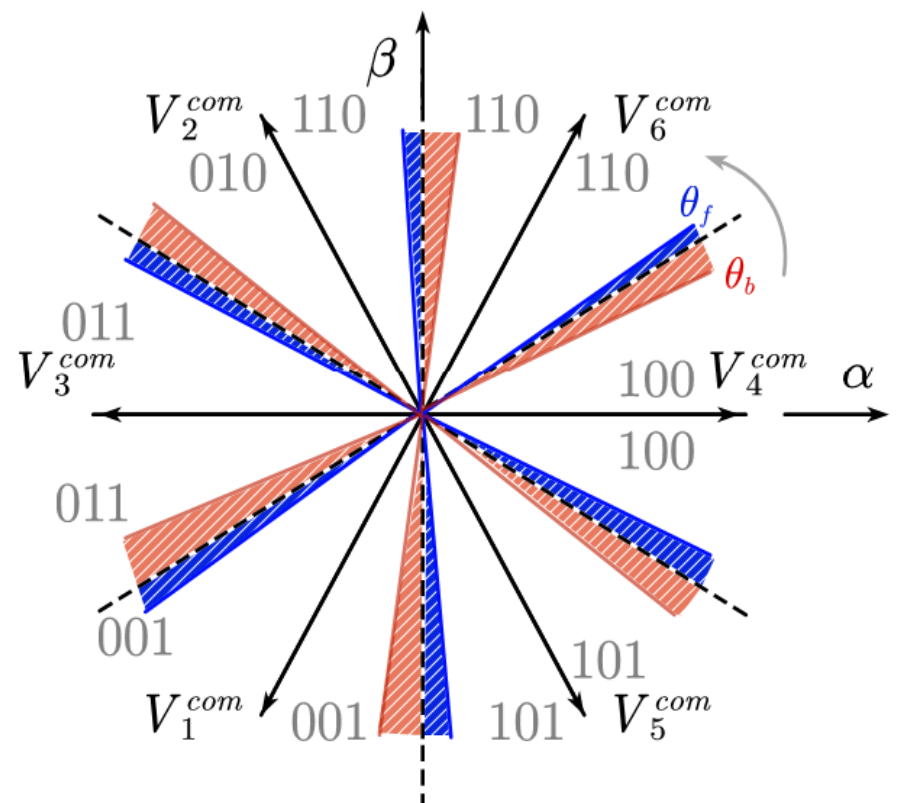
Figure 12. Improved relationship between θ and compensation voltage vectors.